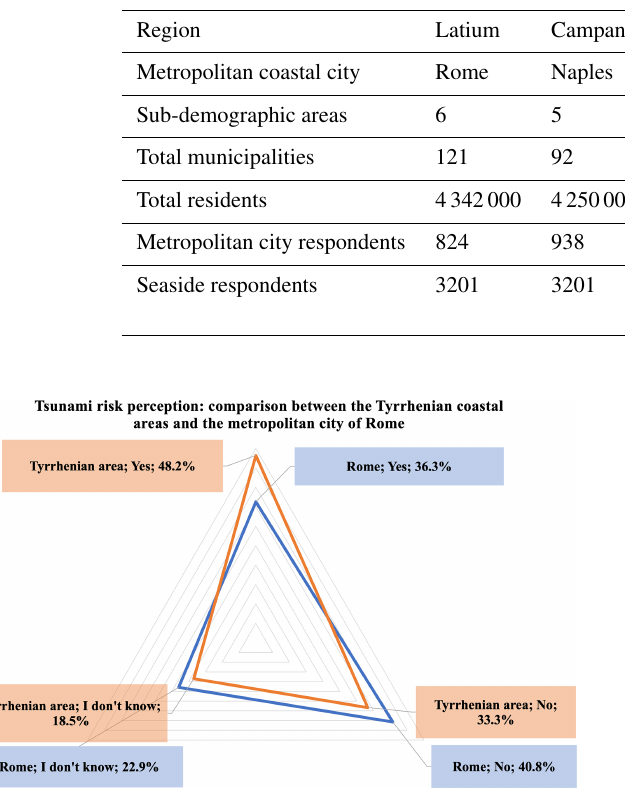
Figure 8. Tsunami risk perception (Q16): comparison between the Tyrrhenian coastal area and the metropolitan city of